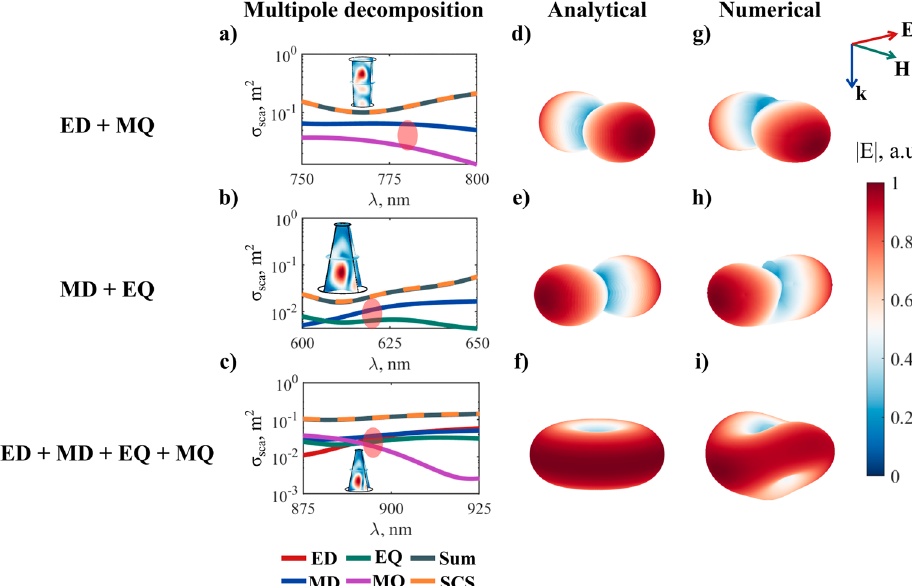
Figure 4. Transverse Kerker effects for truncated conical nanoparticles with different shapes. ( a – c )—multipolar decomposition, ( d – f )—far-field sum of multipoles for a point particle, calculated analytically, ( g – i )–far-field distribution for conical nanoparticles with different geometries calculated numerically for real particles at the spectral points shown in ( a – c ). Conditions of the illumination—incident plane wave from the top of the page. The geometrical parameters for every case can be found in section S3 of the Supplementary Information. The experimental dispersion data for a-Si is shown in Supplementary Fig. S1.